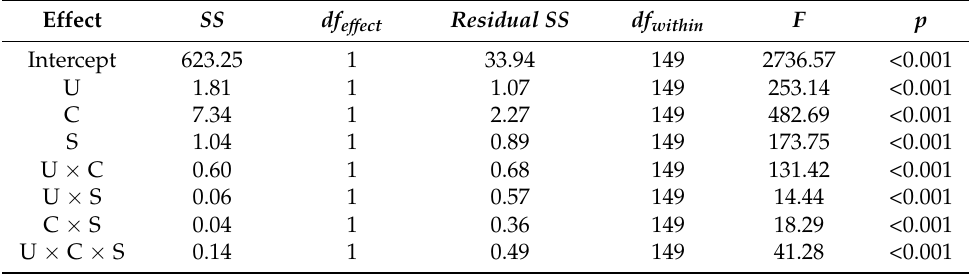
Table A2. Significance testing of mean RT effects using a general linear model with a Gaussian link